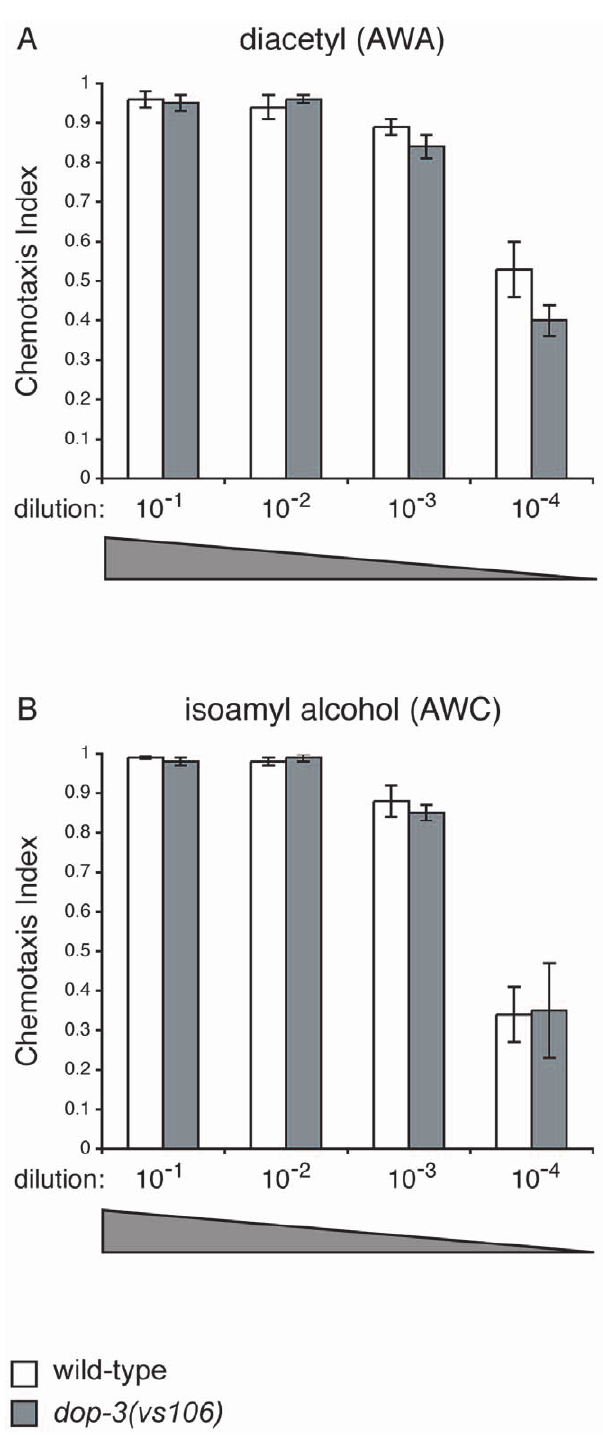
Figure 5. Loss of DOP-3 function does not result in hypersen- sitivity to attractive odorants. The AWA sensory neurons detect the attractive odorant diacetyl, while the AWC neurons detect the attractive odorant isoamyl alcohol [38]. Loss of dopamine receptor DOP-3 function did not lead to enhanced chemotactic responses to dilute concentrations of (A) diacetyl or (B) isoamyl alcohol (p . 0.1 for all concentrations tested of both odorants). Chemotaxis index = (number of animals at odorant– number of animals at control) 4 total number of animals on the assay plate. Each bar represents the average of $ 4 assays with 50–150 animals per trial. Allele used: dop-3(vs106) . WT = the N2 wild-type strain. Error bars represent the standard error of the mean (SEM).